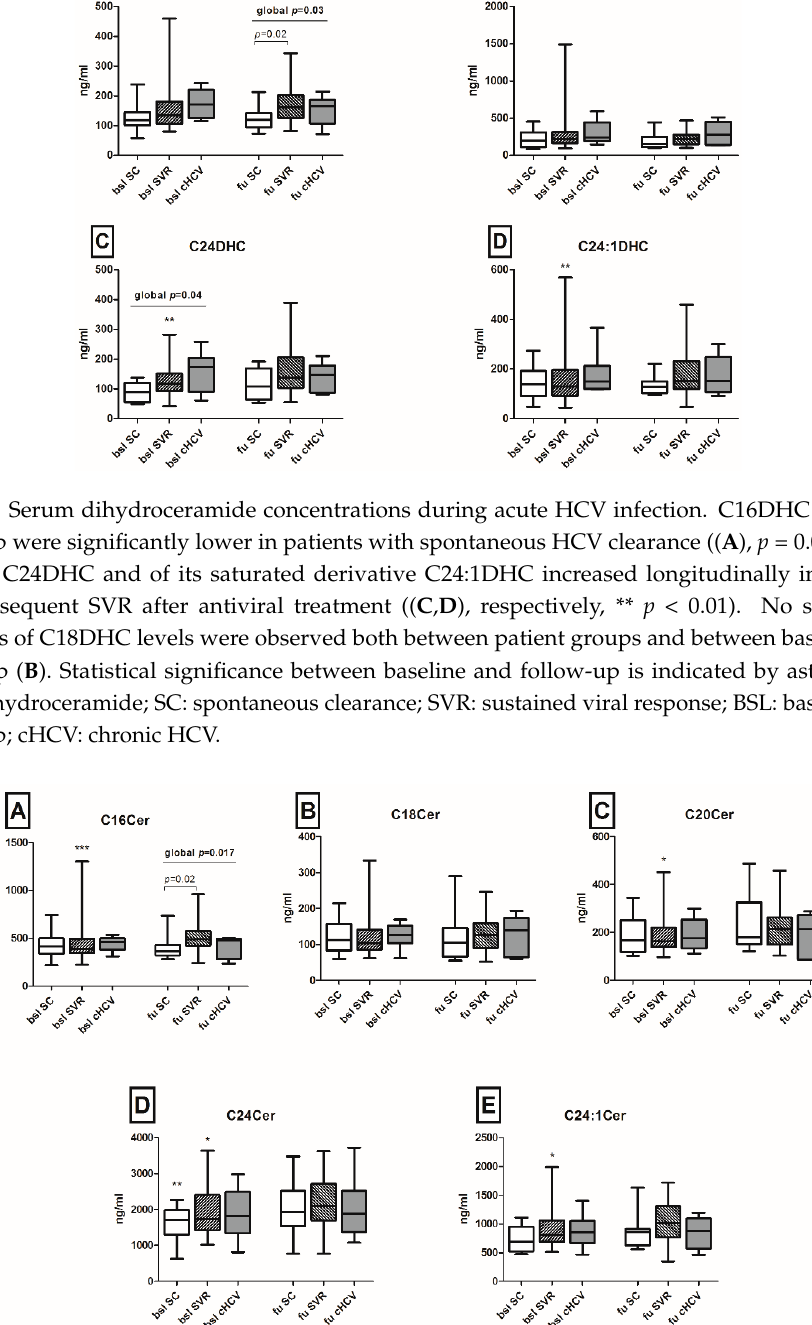
Figure 3. Serum ceramide variations during acute HCV infection. C16Cer, C18Cer, C20Cer, C24Cer and C24:1Cer levels increased during the course of untreated acute HCV infection in patients with subsequent SVR after antiviral therapy (( A ) *** p < 0.001, ( B ) non-significant, ( C ) * p < 0.05, ( D ) * p < 0.05, ** p < 0.01 and ( E ) * p < 0.05, respectively). C24Cer levels increased significantly during the course of acute infection also in patients with spontaneous clearance, as well (( D ), p < 0.01), and on follow-up, C16Cer levels were significantly lower in patients with spontaneous HCV clearance as compared to patients with subsequent SVR (( A ), p = 0.02). Statistical significance between baseline and follow-up is indicated by asterisks (*). Cer: ceramide; SC: spontaneous clearance; SVR: sustained viral response; BSL: baseline; FU: follow-up; cHCV: chronic HCV.